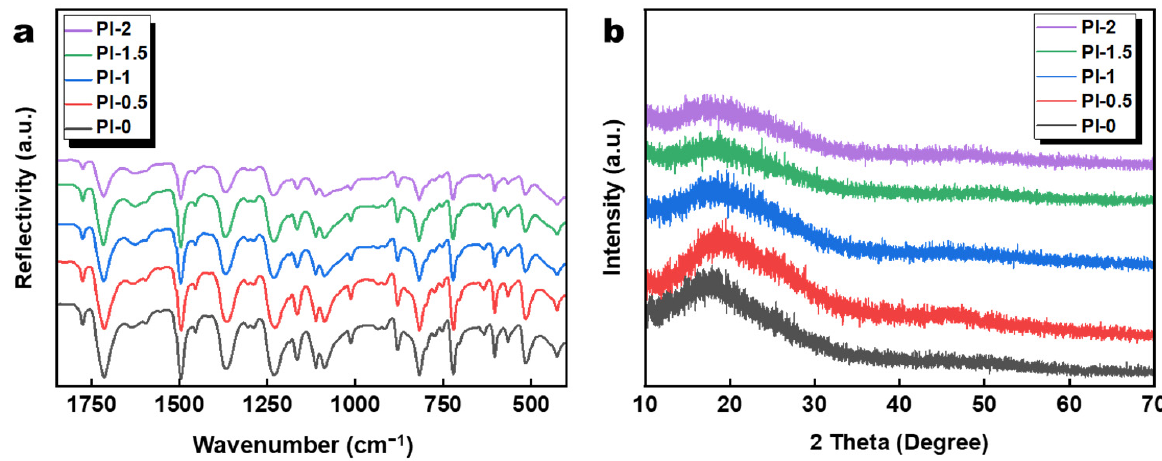
Figure 3. ( a ) FTIR-ATR spectra and ( b ) X-ray diffraction patterns of PI-0, PI-0.5, PI-1, PI-1.5, and PI- 2.